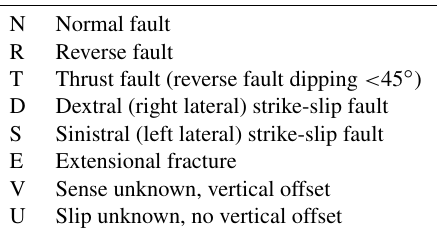
Table 1. Acronyms for fault sense used in the database. N Normal fault